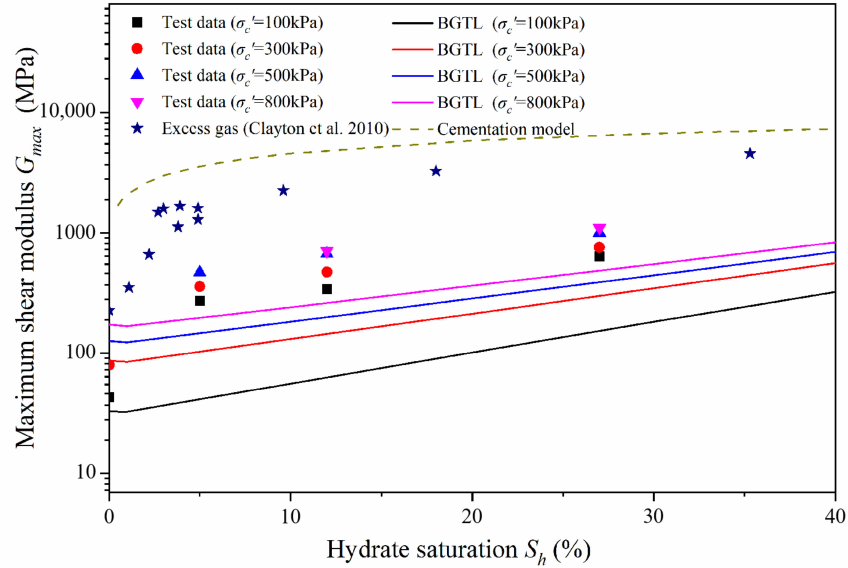
Figure 8. Relationship between the maximum shear modulus and the hydrate saturation